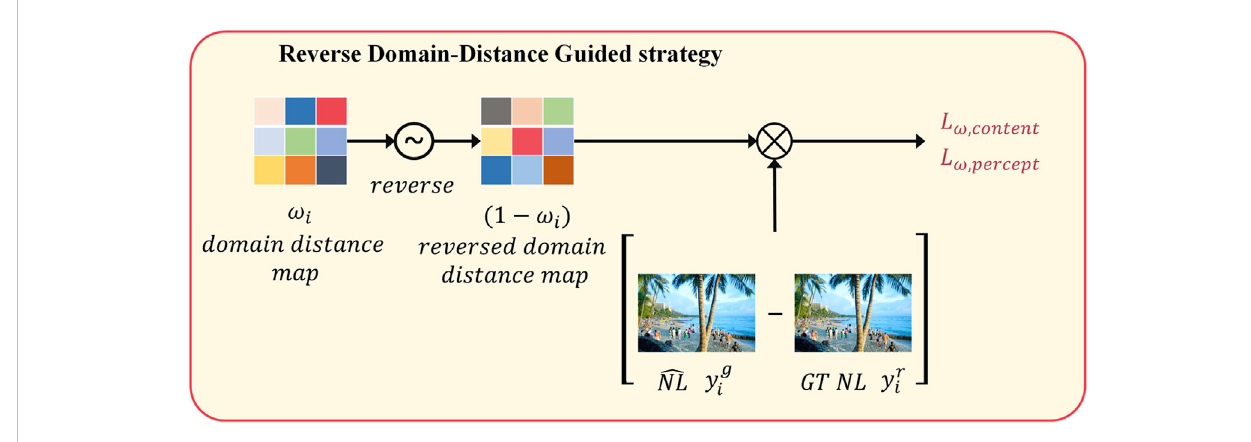
FIGURE 3 The proposed Reverse Domain-Distance Guided strategy. It facilitates the Enlightening Network to be more attentive to the less realistic regions of the input LL